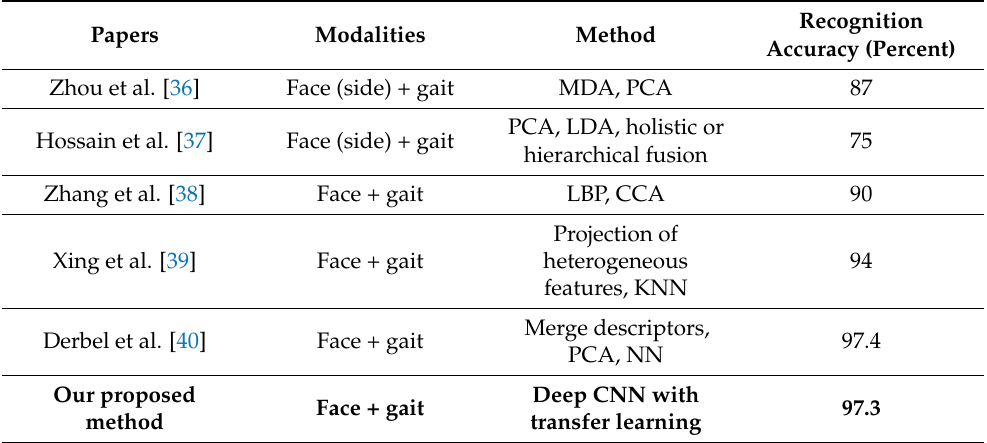
Table 7. Recognition accuracy comparison of various multimodal methods.